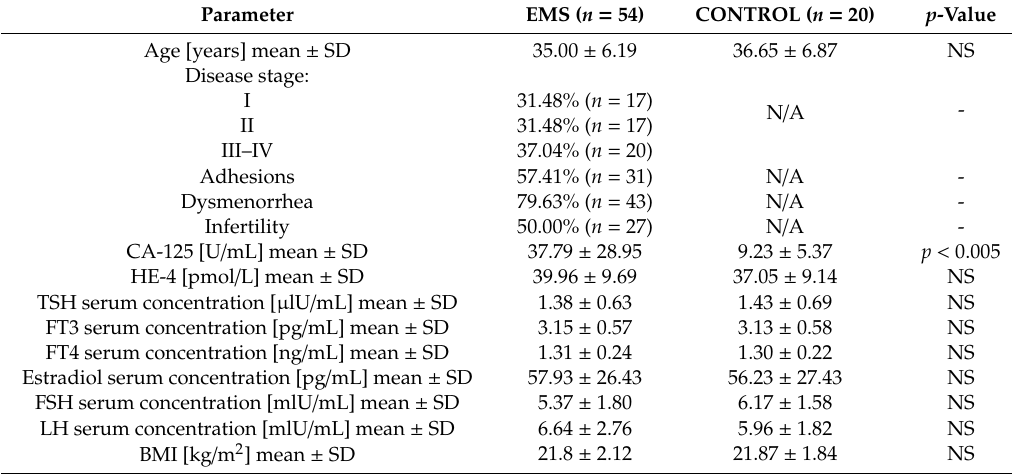
Table 1. Characteristics of the study and the control